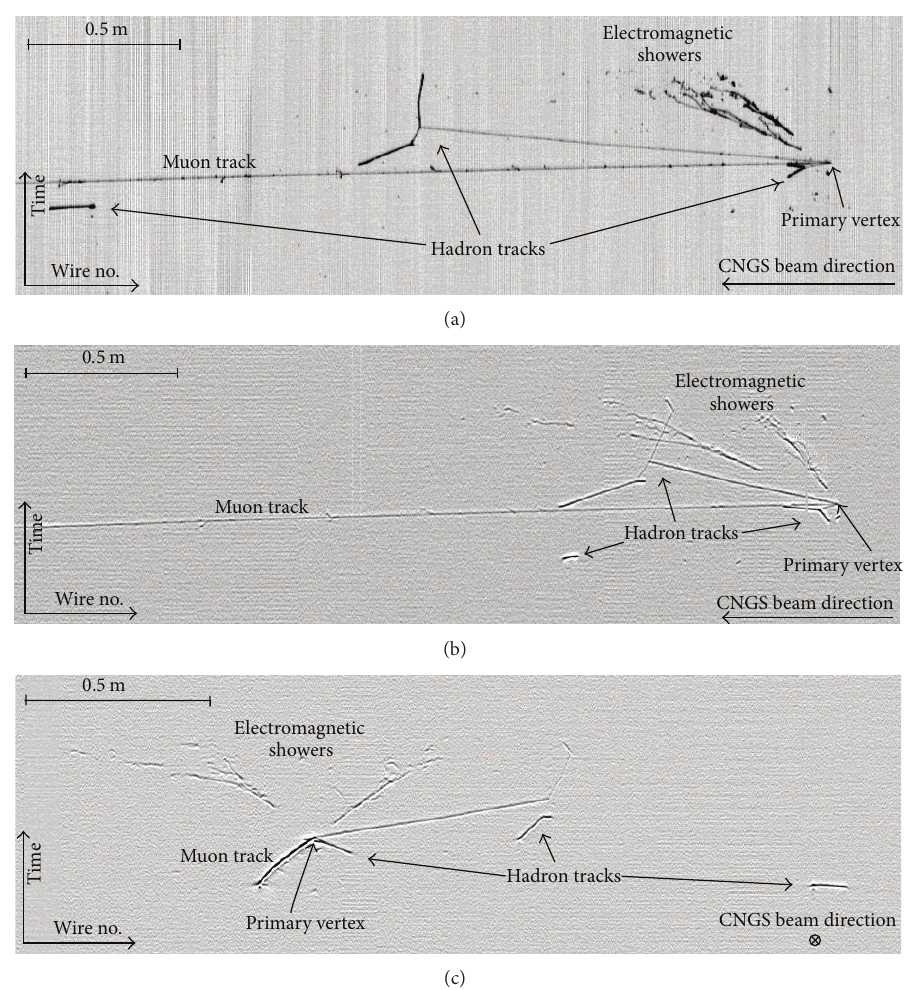
Figure 2: Data: CNGS ] 𝜇 charge current interaction in the ICARUS T600 detector, a fragment of the wire data in one of the detector modules: (a) Collection plane; (b) Induction2 plane; (c) Induction1 plane. The horizontal wires of the Induction1 plane form the projection on XY plane and give the frontal view of the event while the Collection and Induction1 planes form YZ projections and give the top views of the event seen at two